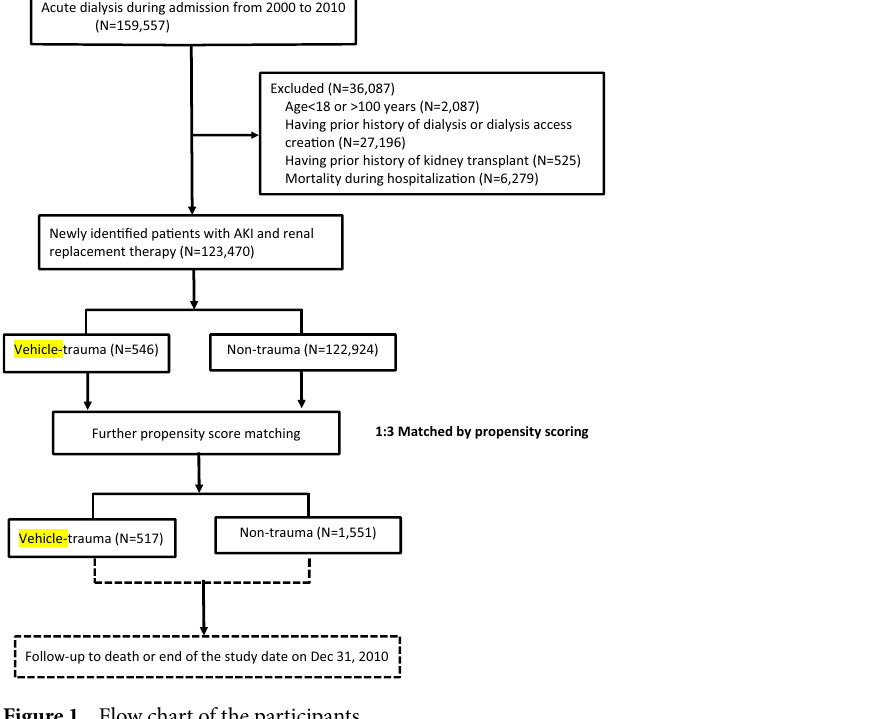
Figure 1. Flow chart of the